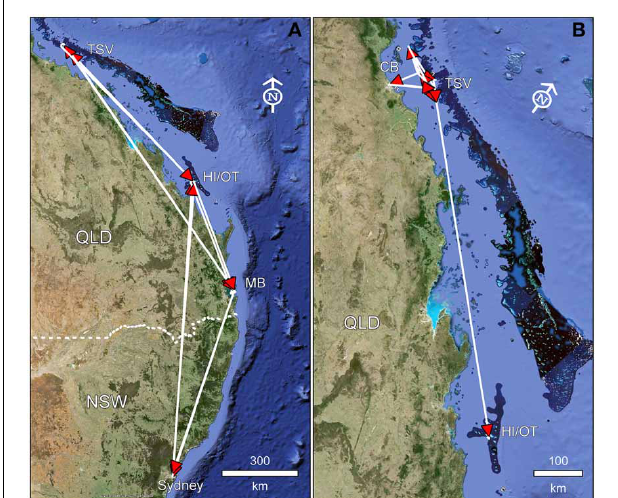
FIGURE 2 | Straight line moves of an individual released in NSW (A) and QLD (B) based on detections on acoustic arrays beyond the site of capture/tagging. TSV, Townsville reefs; HI/OT, Capricorn Bunker reefs; CB, Cleveland Bay; MB, Moreton Bay. Arrowheads indicate direction of movement, panel (B) is a rotated (45 ◦ ) view of the Great Barrier